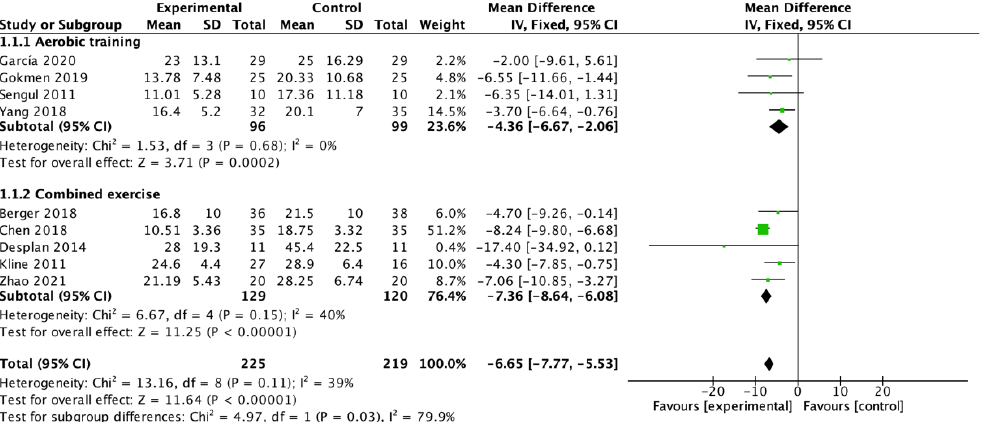
Figure 3. Meta-analysis of the pooled effect of exercise training on AHI and sub-analysis of the pooled effect of aerobic training and combined exercise training on AHI [26 – 34].